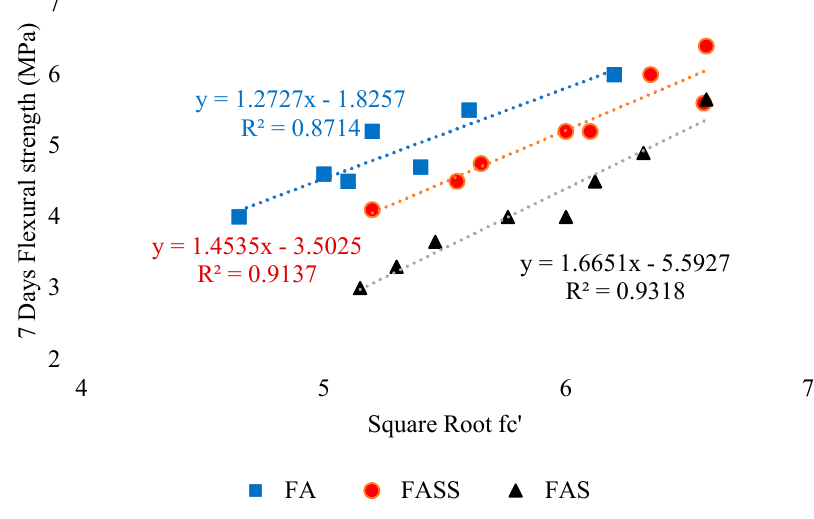
Figure 17. Relationship between square root of compressive strength and flexural strength of different mixes, adopted from [116]; Elsevier, 2018.